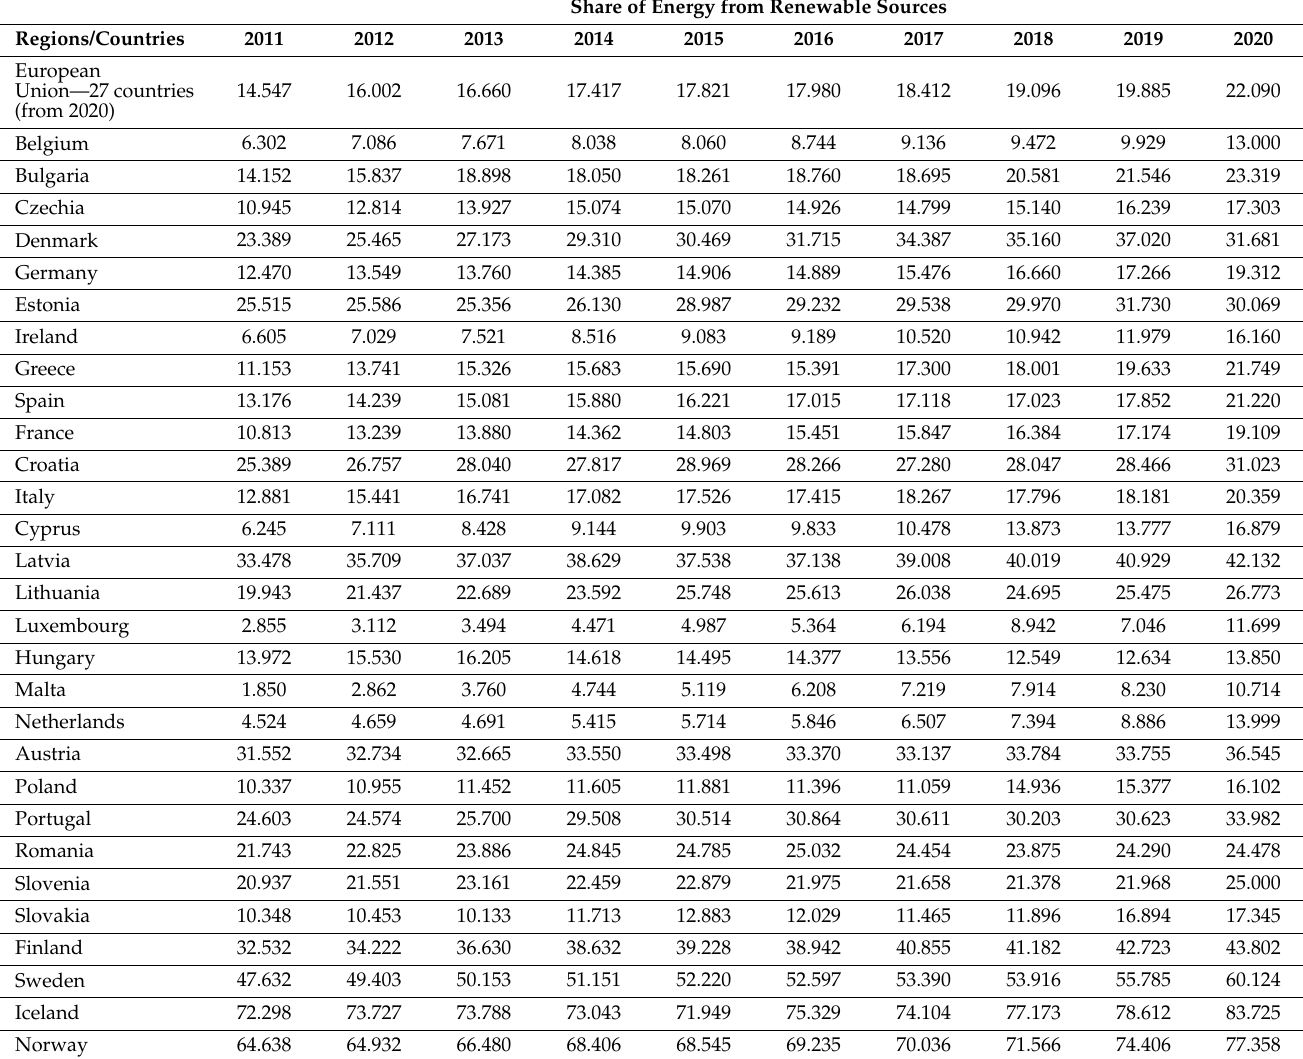
Table 2. Share of energy from renewable sources for selected countries,